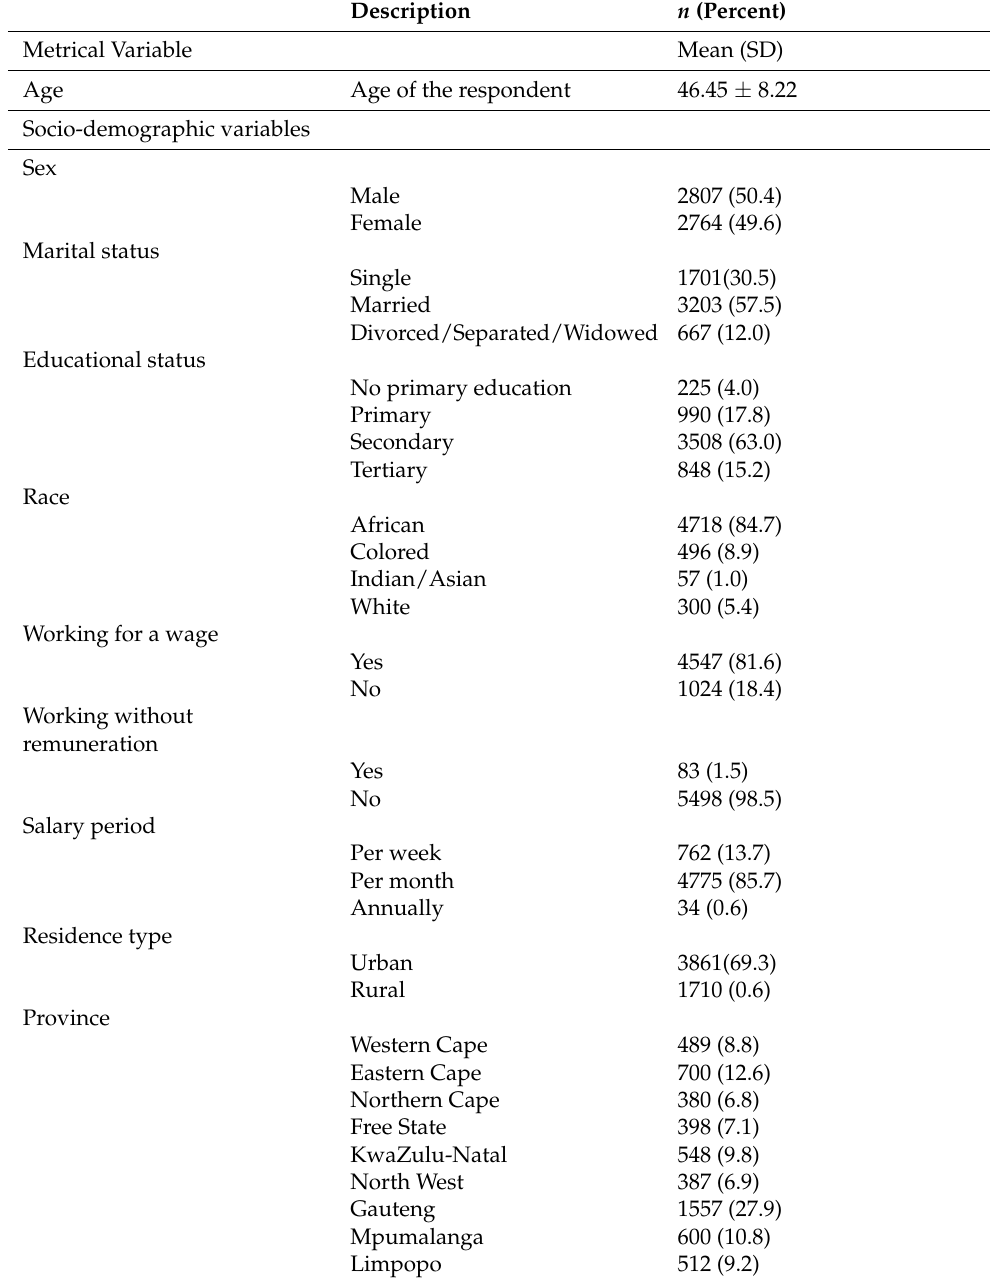
Table 1. Descriptive summary of variables utilized in the